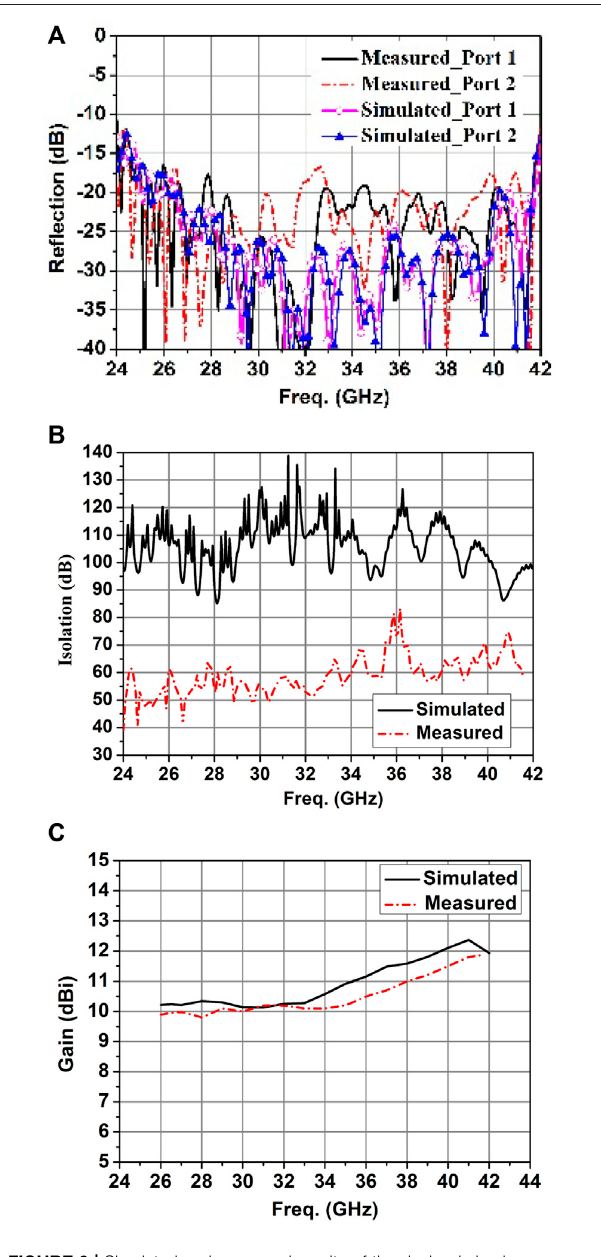
FIGURE 9 | Simulated and measured results of the dual-polarized corrugatedhornantennawithOMT. (A) Re fl ectioncoef fi cient. (B) Isolation. (C)